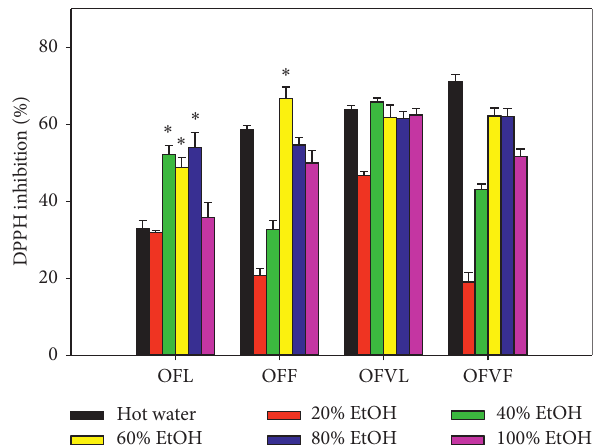
Figure 4: DPPH radical scavenging activity of various extracts of Osmanthus fragrans ( n � 3; ∗ significantly higher than the “hot water” extract).